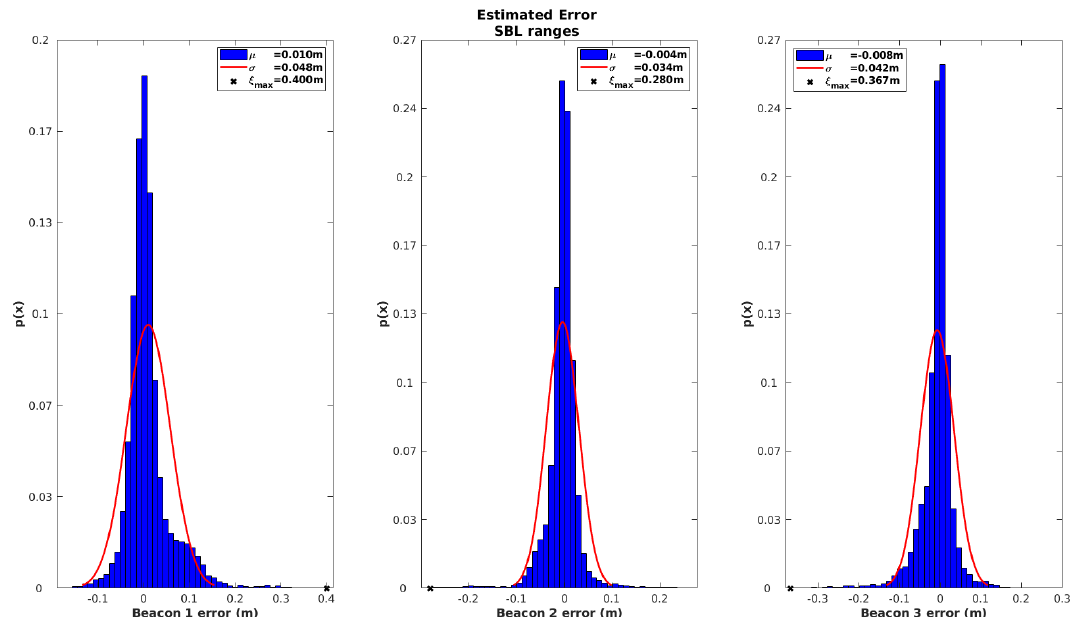
Figure 10. Innovation statistics registered for the observations of each SBL beacon, using the range based